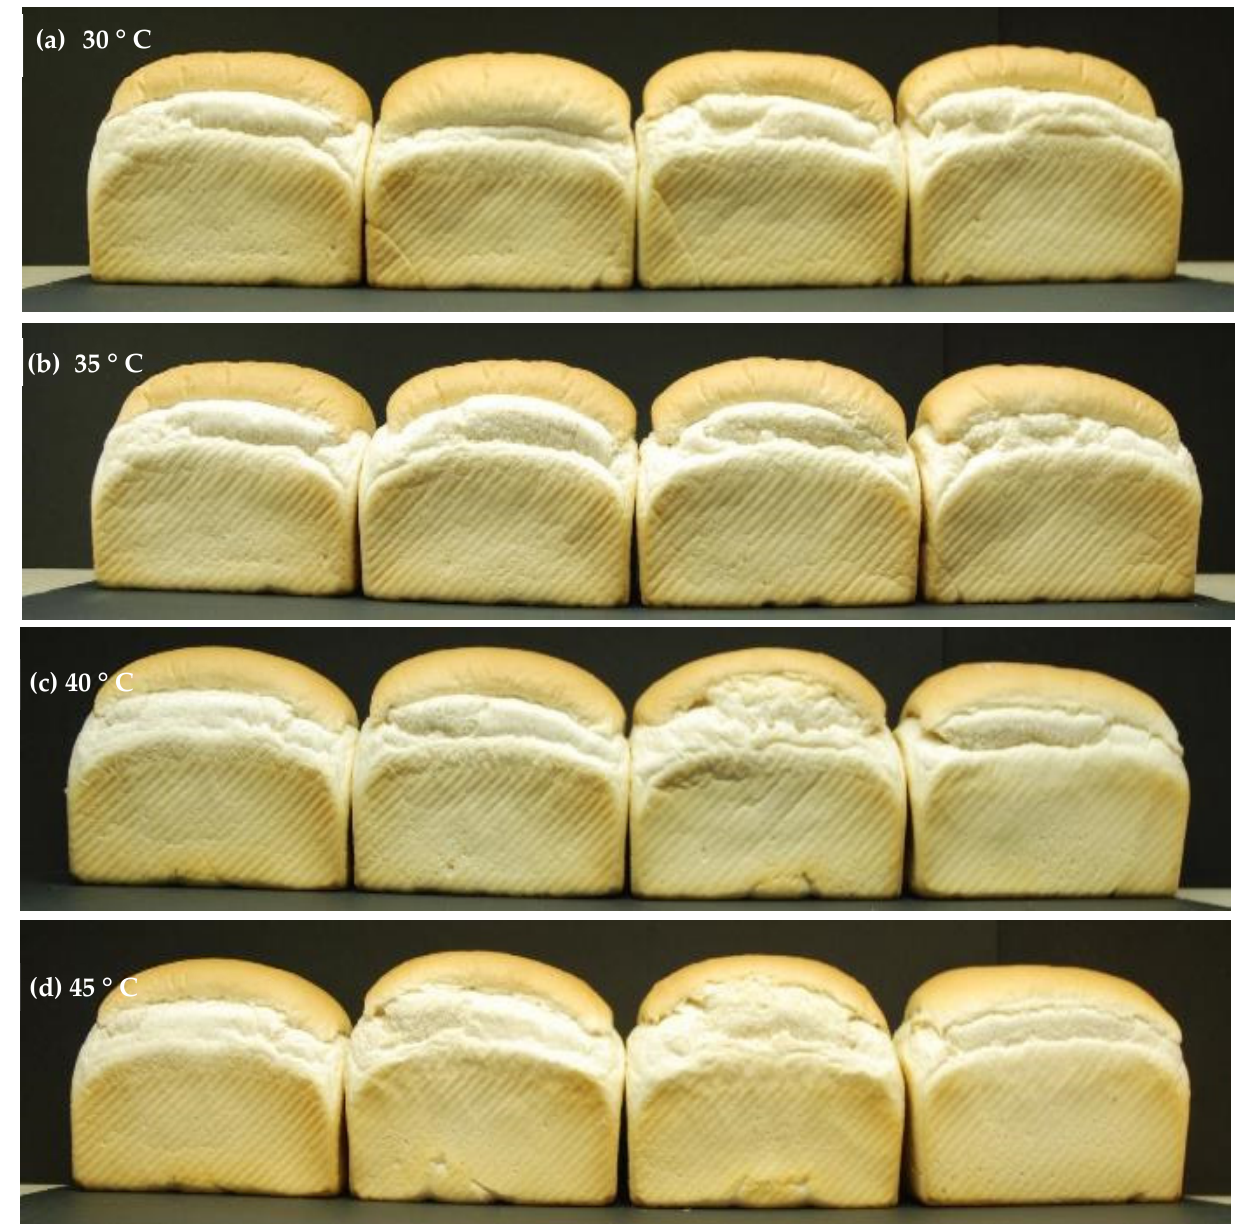
Figure 12. Breads made with ferment prepared using varying fermentation temperatures. ( a ) 30 °C, ( b ) 35 °C, ( c ) 40 °C, and ( d ) 45 °C. Left to right: control (no ferment), 30% ferment inclusion, 50% ferment inclusion, and 70% ferment inclusion.